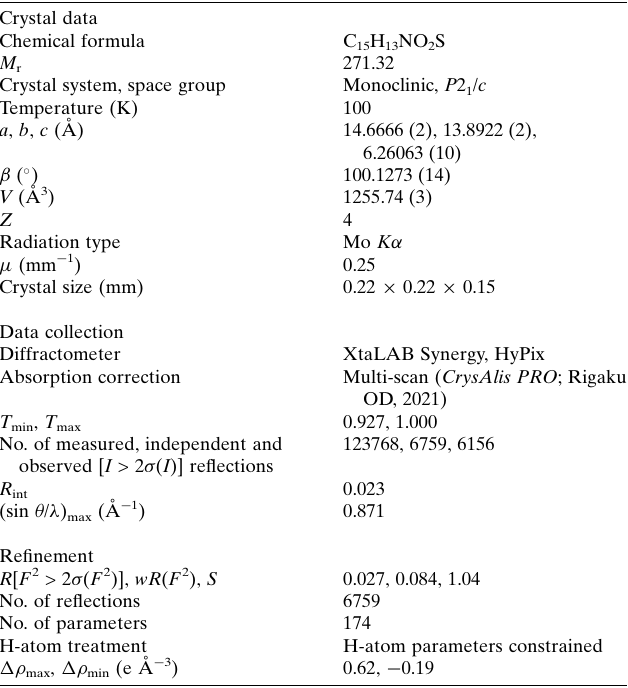
Table 3 Experimental details. Crystal data Chemical